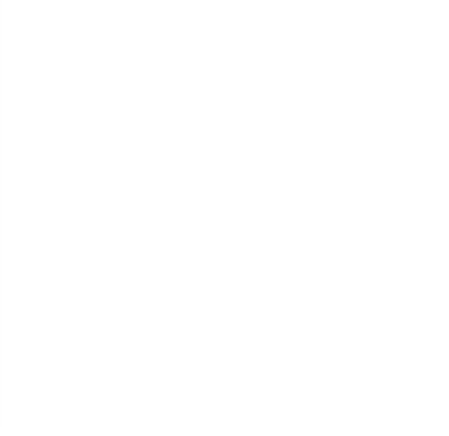
Figure 8. Lock time comparison plot of proposed PLL among various corners at different temperatures.